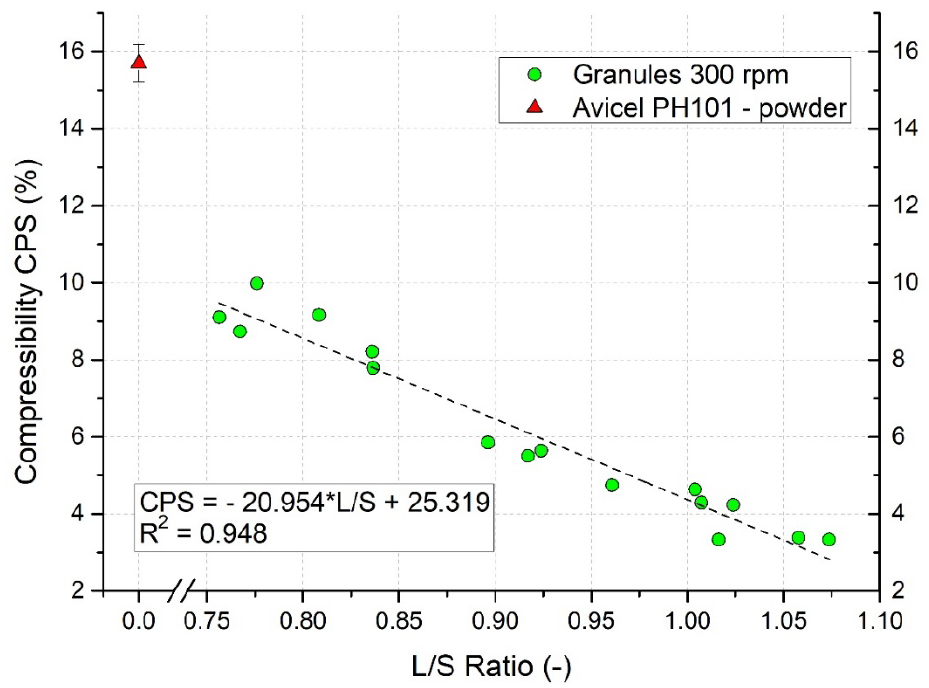
Figure 12. Compressibility of raw Avicel PH101 powder and effect of L/S ratio on compressibility of granules manufactured at 300 rpm impeller speed.